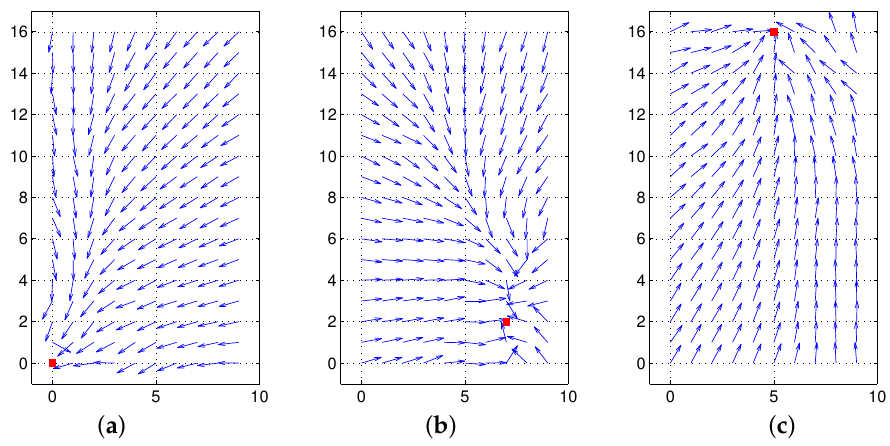
Figure 15. Homing performance for Vardy’s image set without a reference compass; the landmark rearrangement method to align the coordinate and the moment model with estimated distance and color intensity are used: ( a ) home location (0,0); ( b ) home location (7,2); ( c ) home location